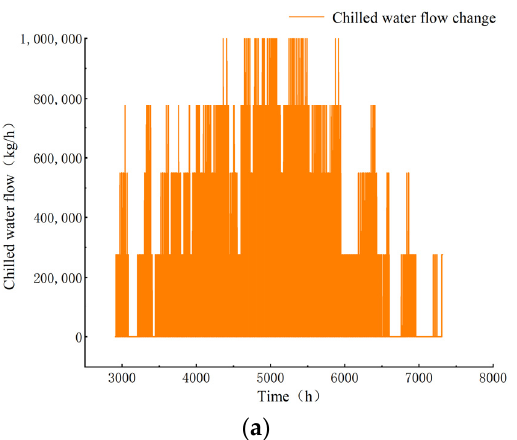
( d ) Figure 11. Chilled water flow under different optimized strategies. ( a ) Chilled water flow under initial operation; ( b ) Chilled water flow under scheme optimization; ( c ) Chilled water flow under parameter optimization; ( d ) Comparisons of annual total chilled water under different optimized methods. 5.3. Operation Parameters and System COP under Different Optimized Strategies Table 4 shows the operating parameters under different optimization. Under initial operation, the difference of supply and return water temperature at the refrigeration side is only 3.22 °C, a lot of water pump power is wasted, and the COP of the system is 3.32. Under the scheme optimization, through the frequency conversion control of the chilled water pump, the supply and return water temperature difference is controlled at 5 °C, the chilled water pump and cooling tower fan operate at full power, and COP of the system is improved to 3.85. After parameter optimization, under the optimal COP (4.18), the sup- ply and return water temperature is significantly higher than the standard temperature (7 °C–12 °C), which are 8.87 °C, 9.46 °C, and 14.88 °C, respectively. The cooling water pump frequency is reduced to 31.88 Hz and the cooling tower fan frequency is reduced to 37.92 Hz. The values of optimized parameters were introduced into the TRNSYS16 model, the COP of the system was 4.2, and the error with the optimization algorithm is 0.5%, which verified the reliability of optimization by the BP network coupled particle swarm optimi- zation algorithm. In summary, after parameter optimization, the COP of the system is improved by 26.5%, reaching 4.2.